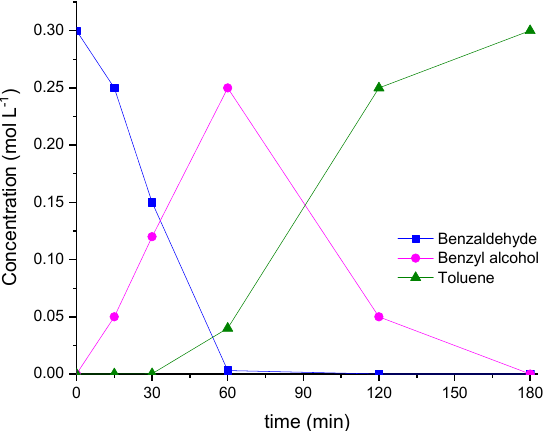
Figure 4. Benzaldehyde hydrogenation/hydrogenolysis reaction. Reaction conditions: 50 °C, 2 bar of H 2 , substrate-to-metal ratio 1000:1, benzaldehyde 0.3 mol L − 1 in p- xylene.